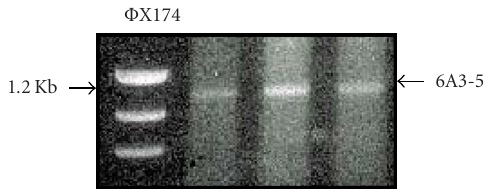
Figure 3. 5 (cid:1) RACE-PCR amplification. A cDNA library (ob- tained from V8 proliferating cells) was used along with a primer coming from the 3 (cid:1) end of the 6A3-5 band. The other primer in the PCR comes from the adapter that is already ligated to the cDNA library. The touchdown PCR technique was used during the 5 (cid:1) RACE, which allowed us to obtain a part of the cDNA. The size of the 5 (cid:1) RACE-amplified 6A3-5 fragment is 1.2kb. φ X174 is given on the left as a molecular weight marker. The lanes rep- resent di ff erent dilutions of the cDNA